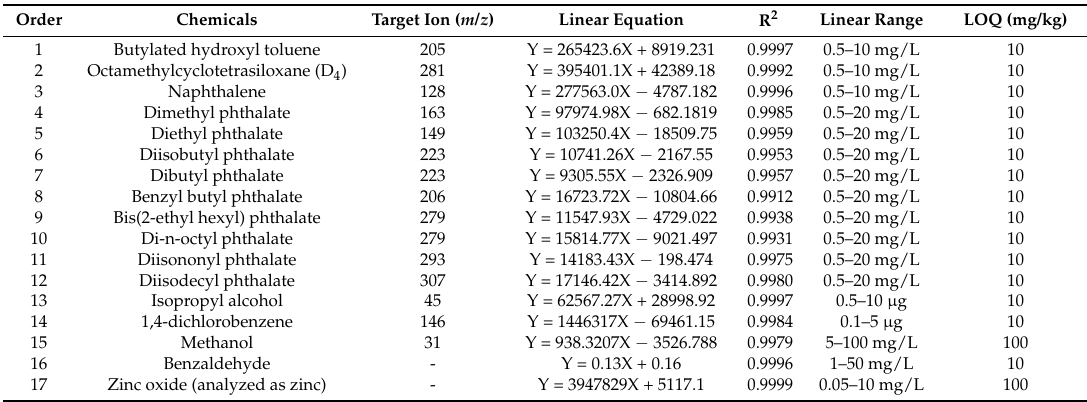
Table 6. Regression equations, correlation coefficients (R 2 ), linear range and limit of quantification (LOQ) of 17 target ingredients